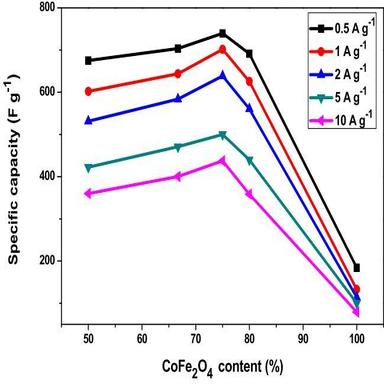
The specific capacitance of CDC/CoFe2O4 composites versus CoFe2O4 content in composites.